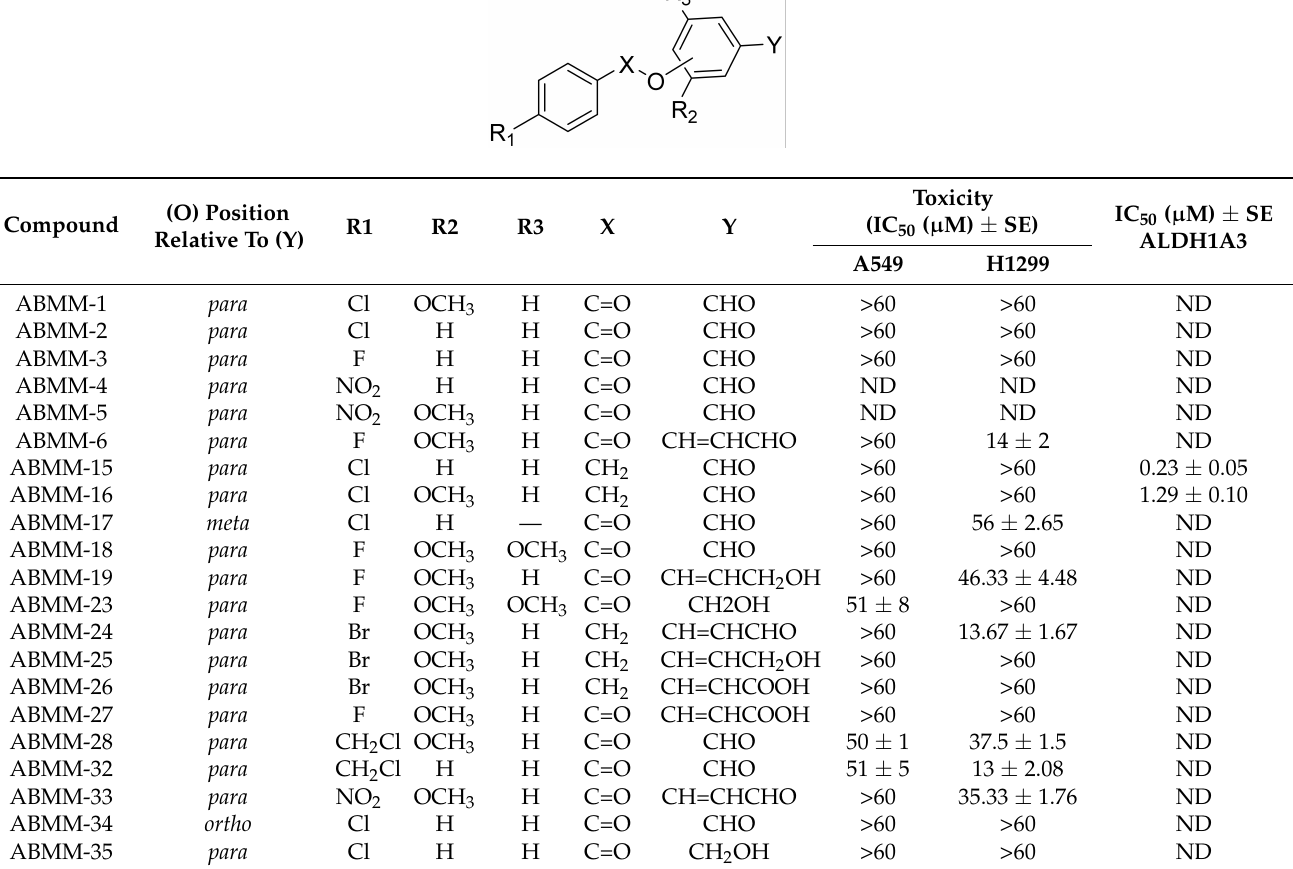
Table 3. The chemical composition of ABMM analogues with IC 50 values against A549 and H1299 cells (following 96 h of exposure) and against the ALDH1A3 enzyme. ND: Not